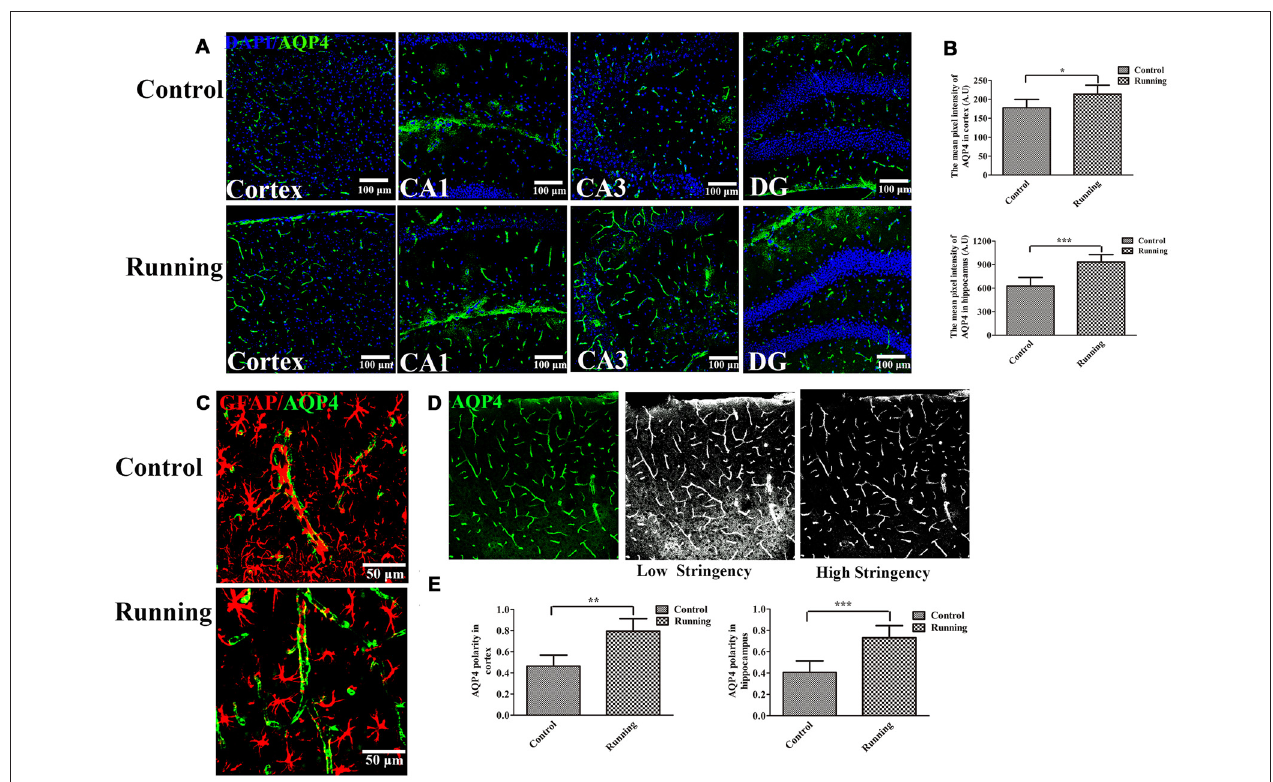
FIGURE 3 | Effects of voluntarily running on aquaporin 4 (AQP4) expression and AQP4 polarity. (A) Immunofluorescent staining of AQP4 in the cortex and hippocampus in the control and running groups (250 × , scale bar = 100 µ m). (B) Histograms comparing the average fluorescence intensity of AQP4 in the cortex and hippocampus ( n = 6 per group). (C) Representative images of AQP4 polarity in the control and running groups (250 × , zoomed in three-fold, scale bar = 50 µ m). (D) Schematic diagram of the calculation of AQP4 polarity. (E) Histograms comparing AQP4 polarity in the cortex and hippocampus ( n = 6 per group). Datasets are expressed as means ± SD. ∗ P ≤ 0.05; ∗∗ P ≤ 0.01; ∗∗∗ P ≤